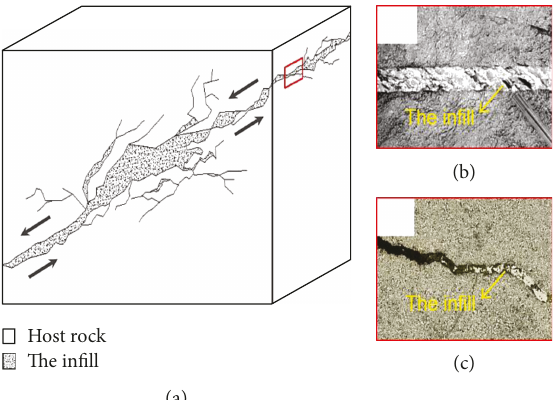
Figure 1: (a) 3D schematic diagram of the in fi ll in a rock mass during shearing. (b) Photograph of a fault with internal alignment of in fi lled materials (modi fi ed from Kirkland et al. [66]). (c) Photograph of a joint fi lled with clay